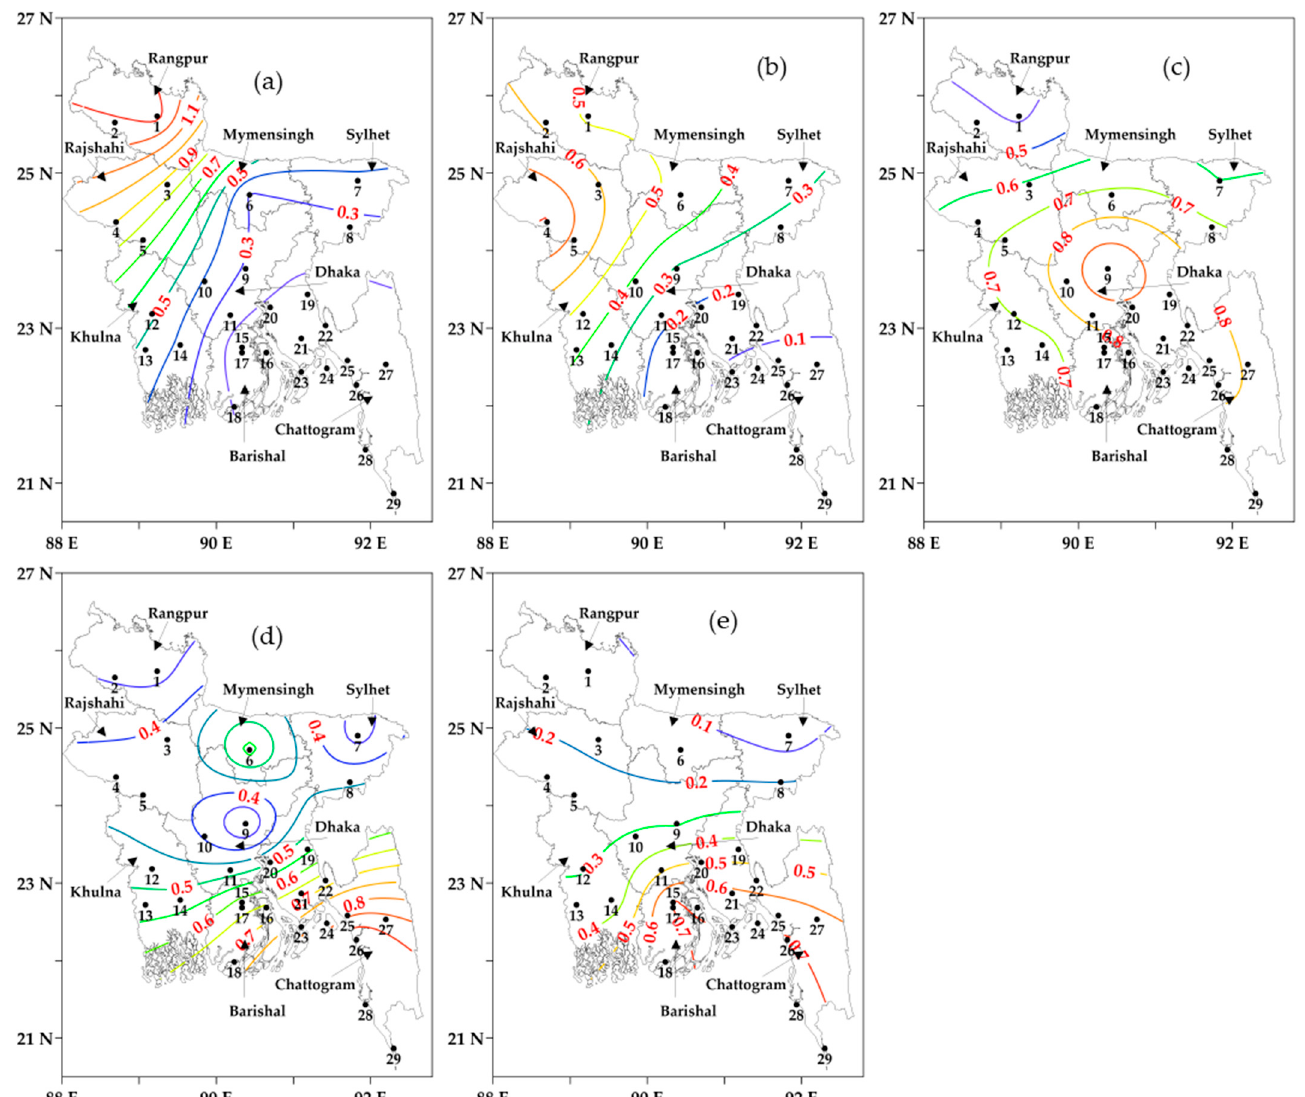
Figure 7. The average number of cold spells (in coloured contour lines with values) in ( a ) Extreme, ( b ) Severe, ( c ) Very, ( d ) Moderate, and ( e ) Mild in different divisions of Bangladesh during the winters of 2000–2001 to 2020–2021. The black numbers are the IDs of meteorological